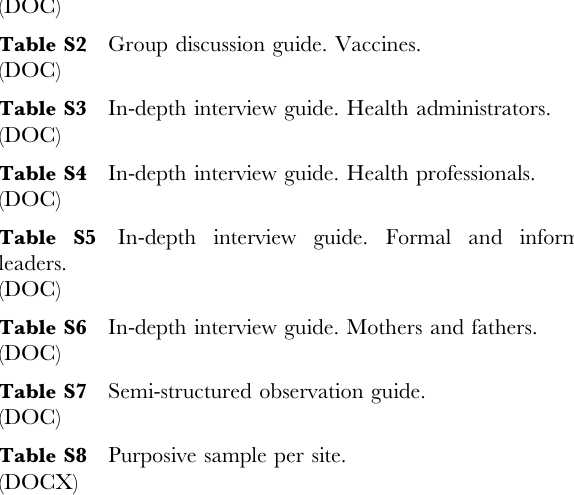
Table S1 Group discussion guide. Malaria. Table S2 Group discussion guide. Vaccines. Table S3 In-depth interview guide. Health administrators. Table S4 In-depth interview guide. Health professionals. Table S5 In-depth interview guide. Formal and informal leaders. Table S6 In-depth interview guide. Mothers and fathers. Table S7 Semi-structured observation guide. Table S8 Purposive sample per